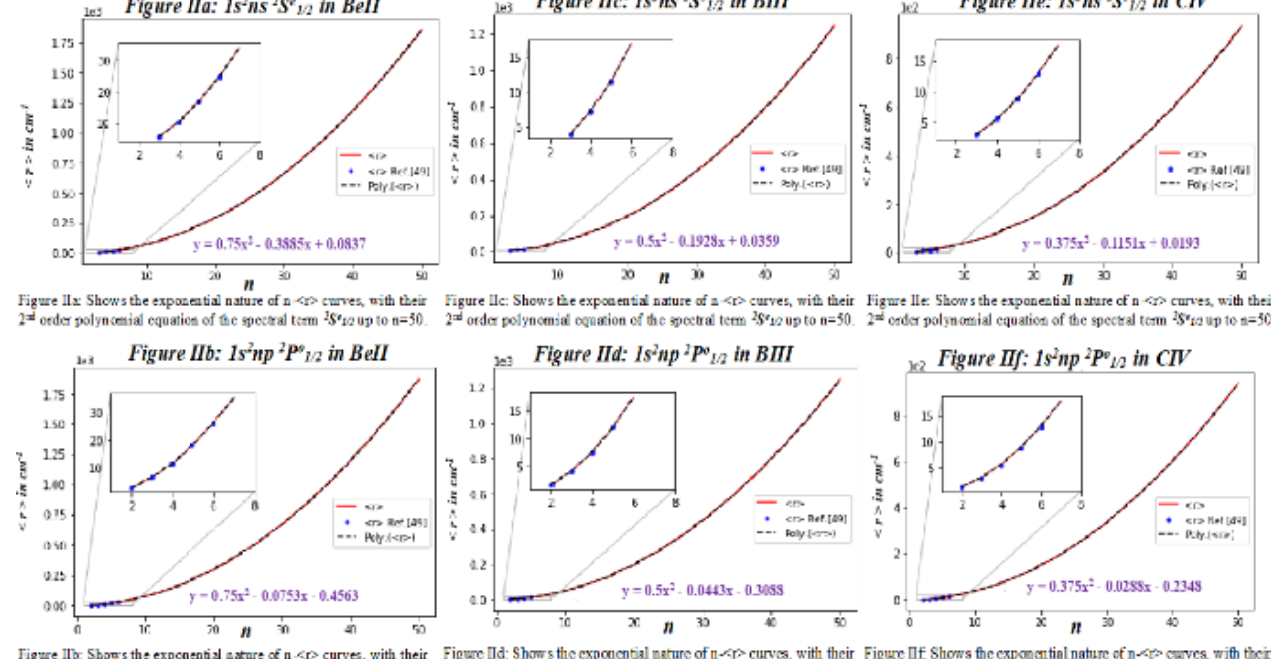
Fig. 2. n-<r> curves show good agreement between computed and previously published excepted value for 1 s 2 ns 2 S e 1/2 and 1 s 2 np 2 P o 1/2 configurations in lithium like-ions for Z = 4-6, up to n = 50. Also presented general 2nd order polynomial equation for each